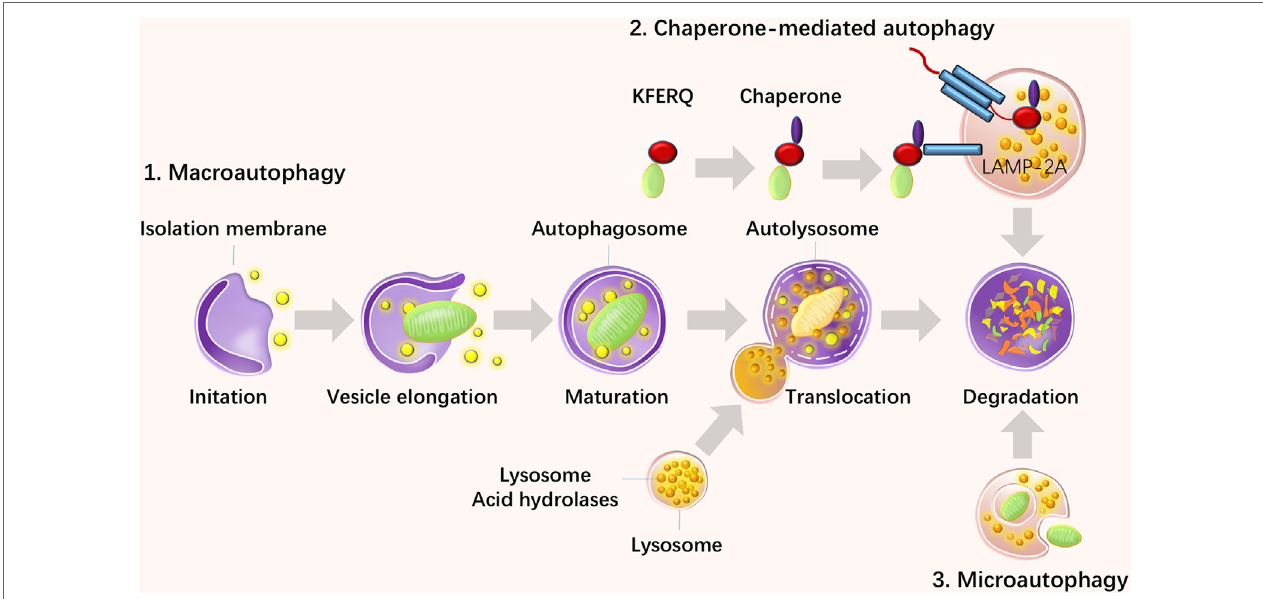
FigURe 1 | Three types of autophagy and their steps. There are three types of autophagy: macroautophagy, chaperone­mediated autophagy (CMA), and microautophagy. Macroautophagy initiates with the recruitment of protein aggregates and misfolded proteins by phagophores. Then, vesicles undergo elongation and form double­membraned vesicles, called autophagosomes, and the cytoplasmic components are enclosed via cargo sequestration and fused with lysosomes for degradation and recycling. CMA is another type of autophagy, which is involved in the direct recognition, targeting, and degradation of substrates by lysosomes rather than autophagosome formation. Microautophagy is a process of lysosomal engulfment of cytoplasmic cargo with the formation of autophagic tubes and vesicles.